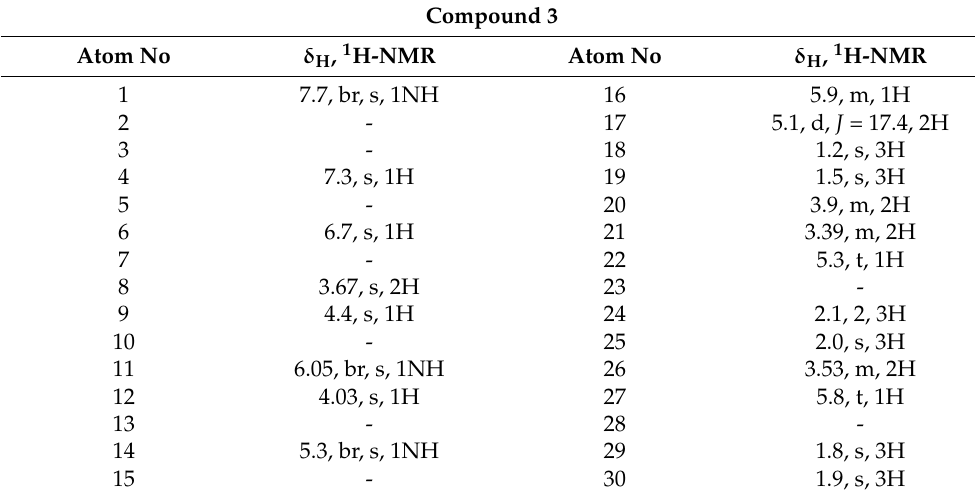
Table 2. 1 H-NMR echinulin derivative (cristatumin B) isolated from A. niger